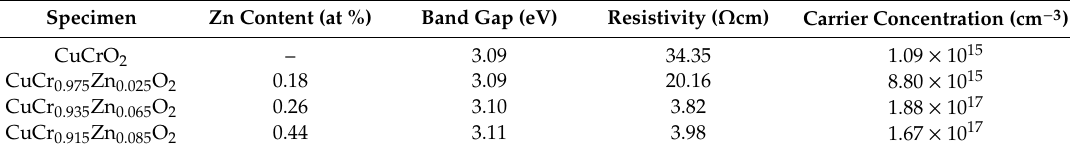
Table 2. CuCr 1 − x Zn x O 2 thin films’ Zn content versus semiconductor